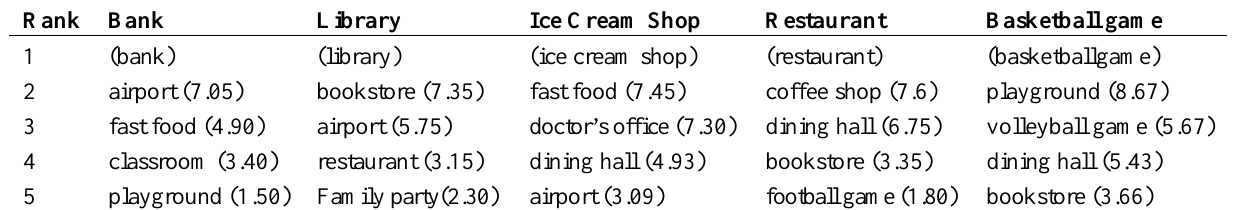
Table 2. The comparison setting names selected in relation to five target names for use in Experiments 1 &